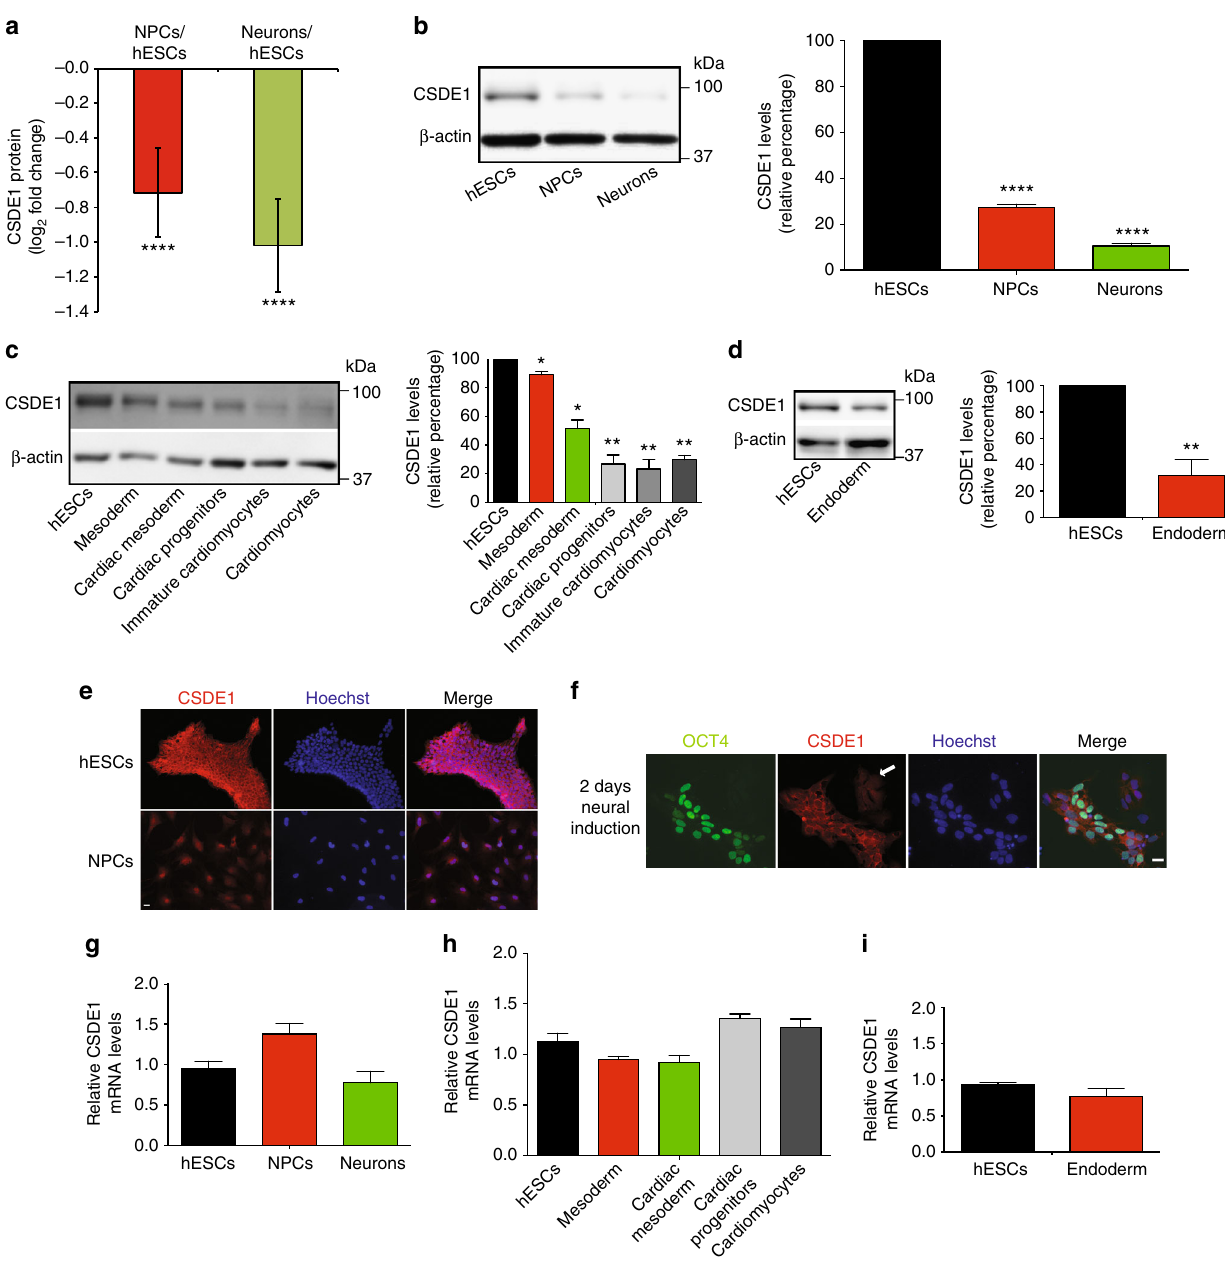
Fig. 1 The levels of CSDE1 protein decrease during hESC differentiation. a Quantitative proteomic analysis of CSDE1 levels comparing H9 hESCs with their NPC and neuronal counterparts. Graph represents the mean ( ± con fi dence interval) of relative abundance differences calculated from the log 2 of label-free quanti fi cation (LFQ) values (hESCs ( n = 9), NPCs ( n = 6) and neurons ( n = 5)). Statistical comparisons were made by limma ’ s moderated t-test ( P -value: **** ( P < 0.0001)). b Western blot analysis with antibody to CSDE1. The graph represents the CSDE1 relative percentage values (corrected for β -actin loading control) to H9 hESCs (mean ± s.e.m. of fi ve independent experiments). c Western blot of CSDE1 in H1 hESCs and their differentiated mesoderm and cardiomyocyte counterparts. The graph represents the CSDE1 relative percentage values (corrected for β -actin loading control) to H1 hESCs (mean ± s.e.m. of two independent experiments). d Western blot analysis with antibody to CSDE1. The graph represents the CSDE1 relative percentage values (corrected for β -actin loading control) to H9 hESCs (mean ± s.e.m. of three independent experiments). e Immunocytochemistry of H9 hESCs and NPCs (2 weeks under neural induction treatment) with antibody to CSDE1. Hoechst staining was used as a marker of nuclei. Scale bar represents 20 μ m. f Immunocytochemistry of cell cultures at early stages of the neural induction treatment (2 days) with antibody to CSDE1. OCT4 and Hoechst staining were used as markers of pluripotency and nuclei, respectively. These cultures contain undifferentiated (OCT4-positive) and differentiated (OCT4-negative) cells. White arrow indicates OCT4-negative cells. Scale bar represents 20 μ m. g Quantitative PCR (qPCR) analysis of CSDE1 mRNA levels. Graph ( CSDE1 relative expression to H9 hESCs) represents the mean ± s.e.m. of three independent experiments. h CSDE1 relative expression to H1 hESCs represents the mean ± s.e.m. of three independent experiments with three biological replicates. i CSDE1 relative expression to H9 hESCs represents the mean ± s.e.m. of two independent experiments with three biological replicates. In b – d and g – i , statistical comparisons were made by Student ’ s t -test for unpaired samples. P -value: *( P < 0.05), **( P < 0.01), **** ( P <